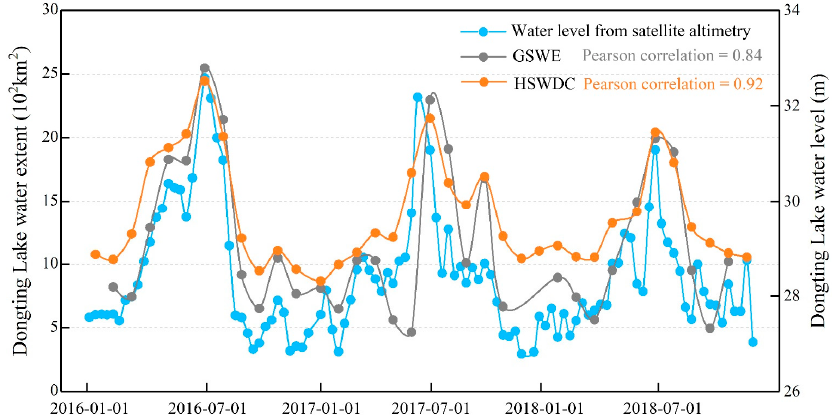
Figure 8. A comparison of time series of the surface water extent derived from HSWDC (shown in orange), GSWE (shown in gray), and water level from satellite altimetry (shown in blue) during 2016 to 2018.